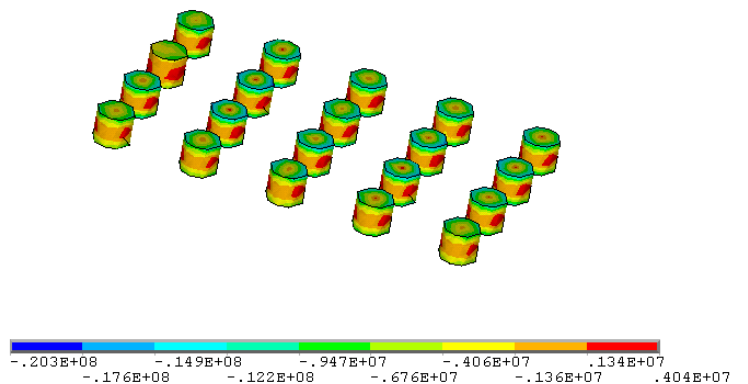
Figure 19. Maximum principal stress distribution of scheme 2 pillars at 1480 mL (parameters of scheme 2: stope height 2.5 m, pillar diameter 3 m, pillar spacing 6 m, pillar row spacing 8 m).